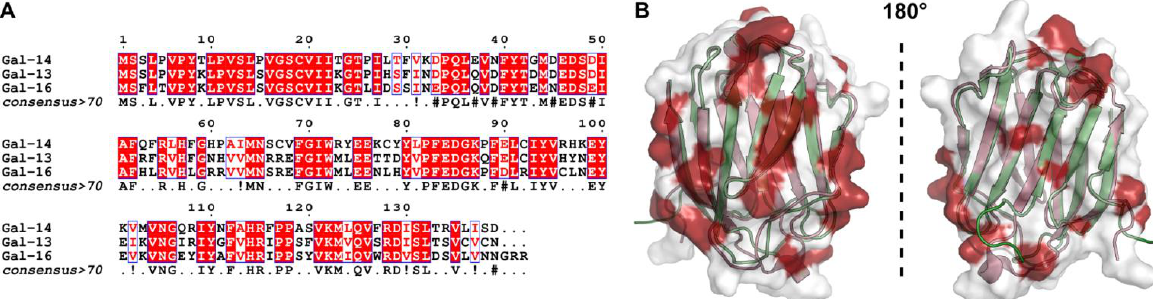
Figure 5. Structural and sequence homology between placental galectins. ( A ) Multiple sequence alignment between GAL-14, GAL-13, and GAL-16. The bottom consensus sequence was defined with a global score similarity threshold of 70%. Overall sequence identity is 68% between GAL-13 and GAL-14, 61% between GAL-14 and GAL-16, and 76% between GAL-13 and GAL-16. All sequences are numbered on top according to the consensus. Strictly conserved residues are highlighted in white font in red boxes. Conservation of residues Asn, Asp, Gln, Glu (#) and Ile, Val (!) are labeled in the consensus. The multiple sequence alignment was performed using Clustal Omega and visualized using ESPript 3.0. ( B ) Overlay between GAL-13 (purple cartoon) and GAL-16 (green cartoon) CRDs illustrates strong structural similarity (76% sequence identity). Electron density representation highlights surface positions that are conserved (white surface) or distinct (red surface) between both galectins. Since GAL-13 and GAL-16 share strong sequence homology, many residues form similar three-dimensional white surface epitopes that likely explain antibody